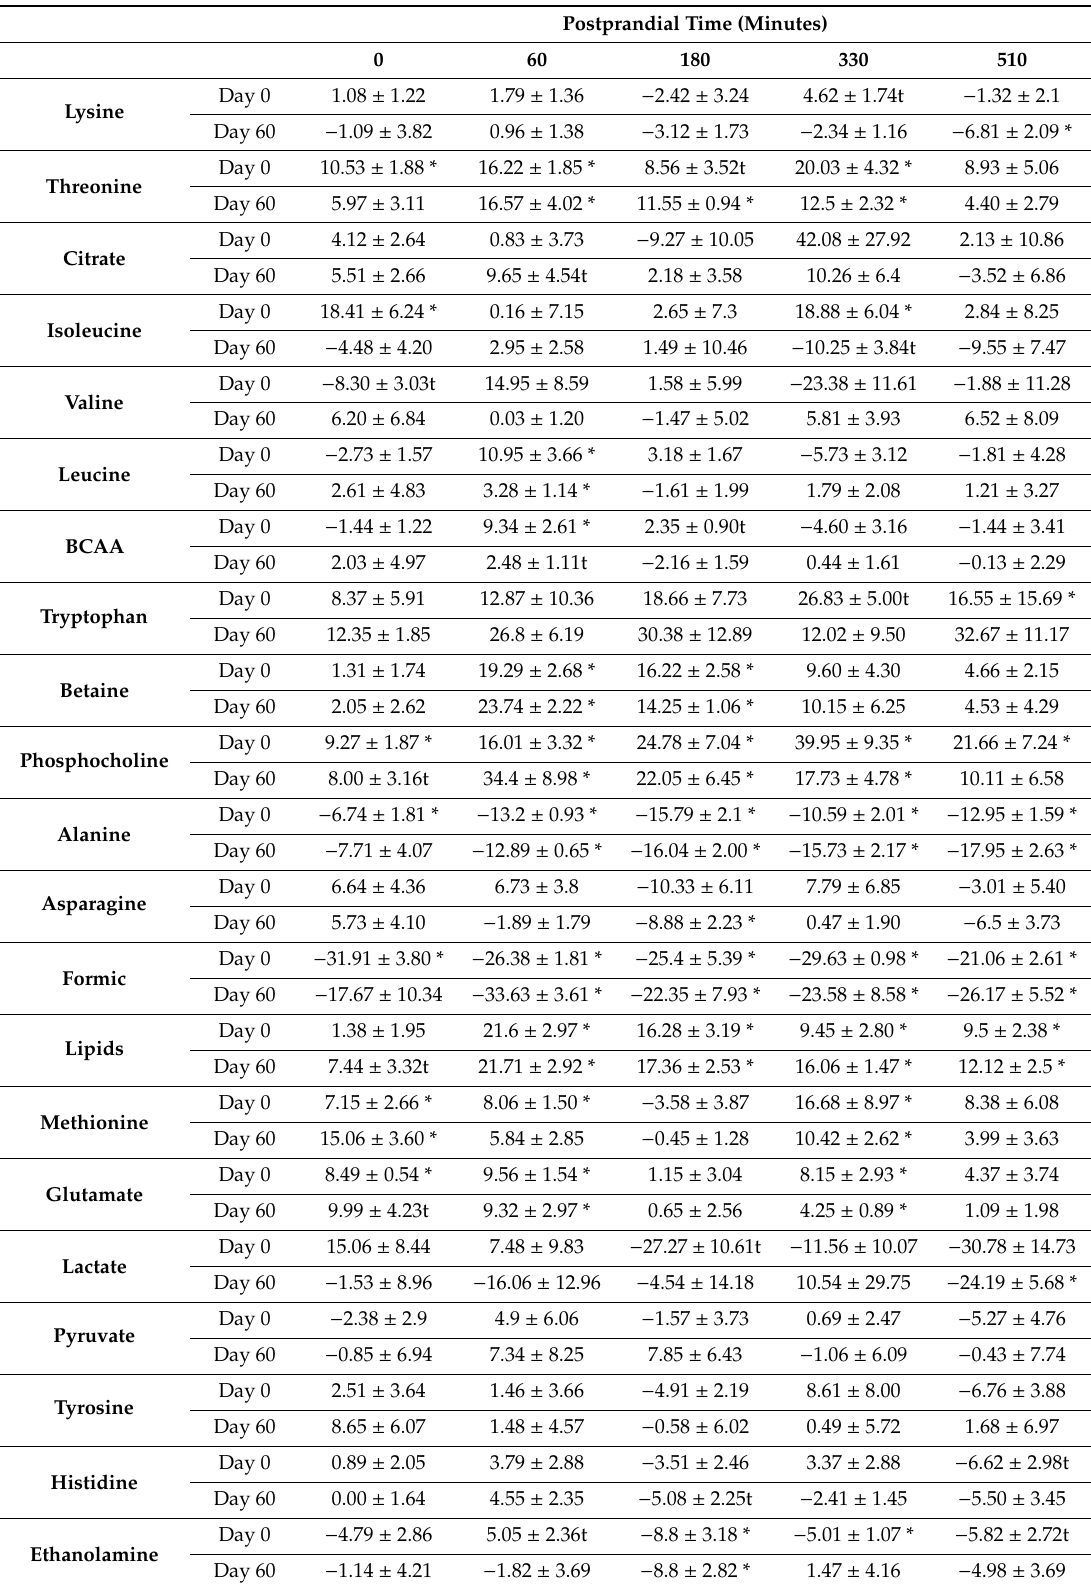
Table 2. Percentage of induction of metabolites across the